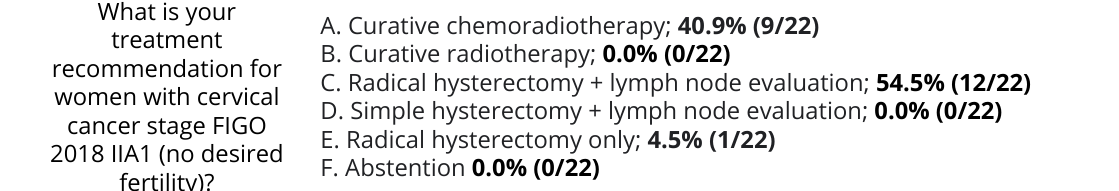
Key issues in the management of cervical cancer: consensus recommendations by a Brazilian expert panel Brazilian Journal of